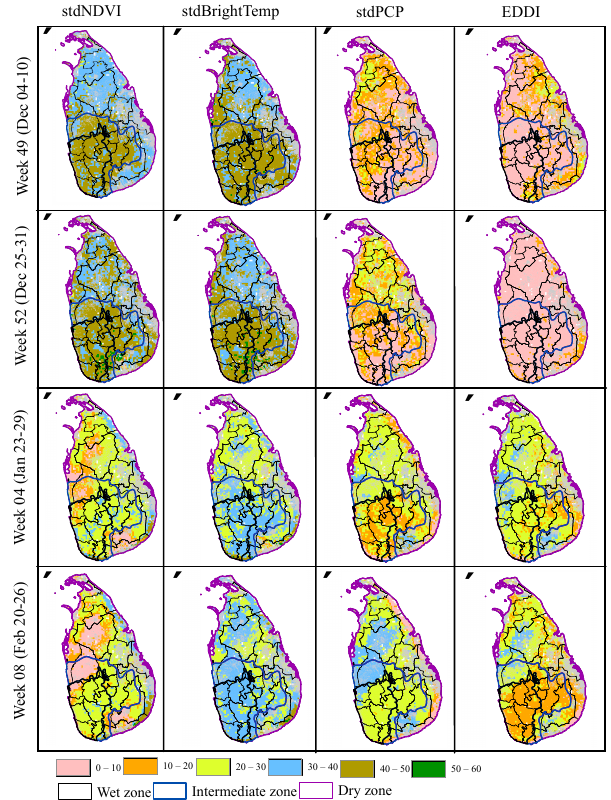
Figure A1. Maha season.